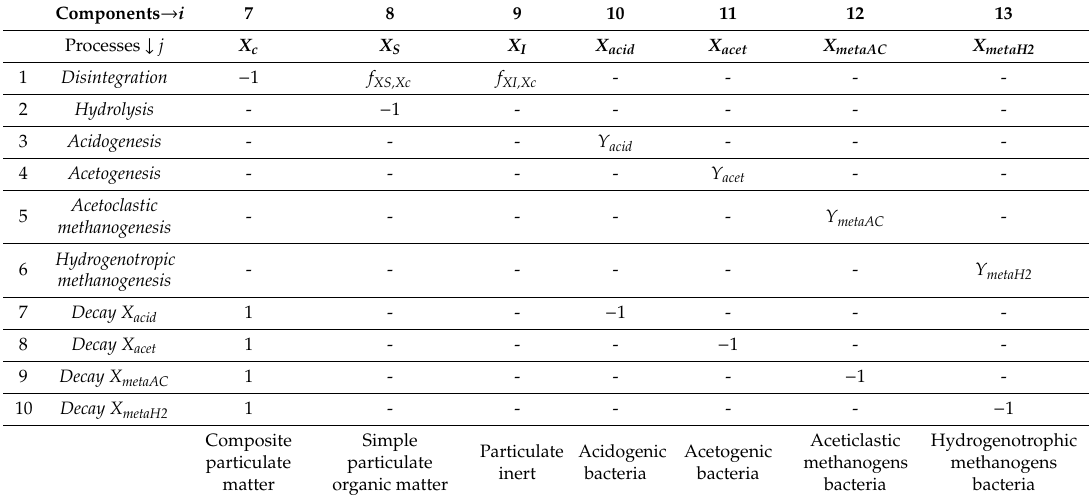
Table 2. Biochemical coe ffi cients ( α i,j ) for particulate matter ( i = 7–13, j = 1–10).